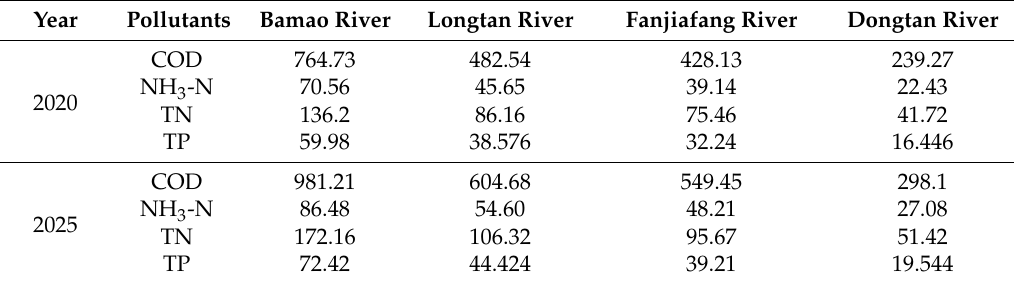
Table 8. The predicted values of the pollutant loads in the tributaries of the Huangshi Reservoir in 2020 and 2025 (units: tons/year).